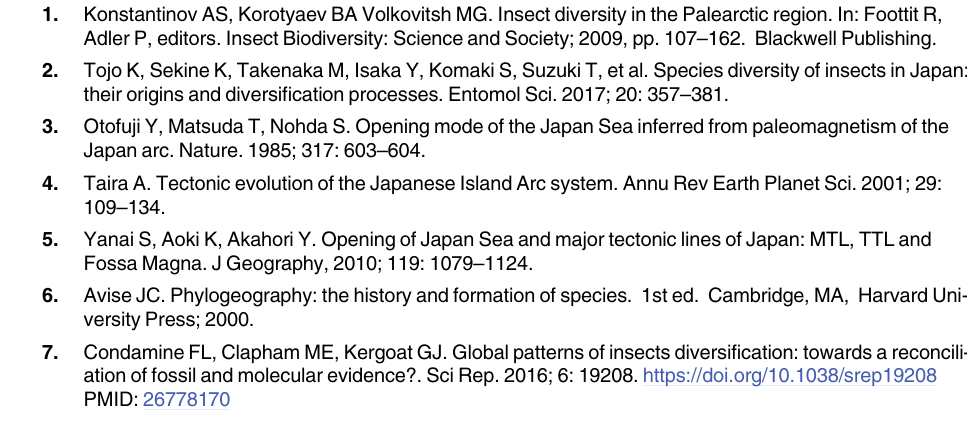
S2 Fig. Putative formation of the Japanese Archipelago [2], [3], [4], [5]. (A) Around 30 to 130 Ma, the Japanese landmasses were located in two major tectonic plates from the Eurasian continent. (B) Around 15 to 30 Ma, the Japanese landmasses began to separate from Eurasia and the North American Plates began to separate from the Eurasian continent, and remained separated by a sea zone called Fossa Magna—a geological event called double-door. (C) Cur- rent map of the Japanese Archipelago in East Asia, where the names of the four main Japanese islands and the two tectonic lines are shown. The maps was prepared using QGIS v 2.18 under the GNU free Documentation License with political boundaries from the Global Database of Administrative Areas